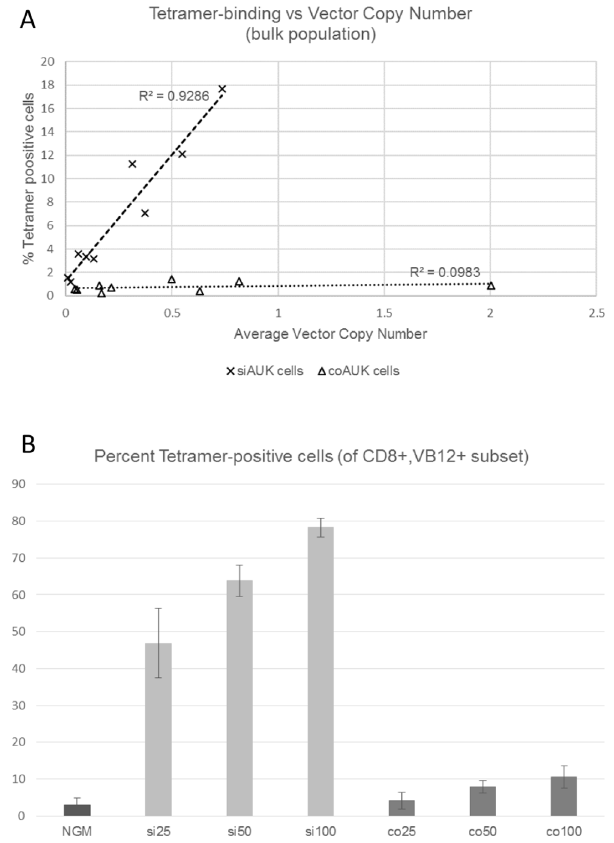
Fig 1. Binding of AURKA tetramer by transduced CD8+ effector cell populations. CD8+ cells from three donors were transduced with siAUK or coAUK vectors, at a range of MOIs (vector supernatant applied to Retronectin-coated plates at 25%, 50%, and 100% of usual volume, diluted where appropriate with fresh culture medium). Binding of fluorophore-conjugated AUK 207-215 /HLA-A * 0201 tetramer was analysed by flow cytometry. Genomic DNA was also collected, and vector copy number determined by qPCR. (A) Tetramer- binding and vector copy number were compared for the population as a whole. Correlation coefficients were compared using Preacher ’ s calculation (p < 0.05). (B) Cells were also labelled for CD8+, and V β 12 transgene expression. Cells from each MOI sample were gated for CD8 and V β 12 positivity, and the percentage of tetramer-binding cells was